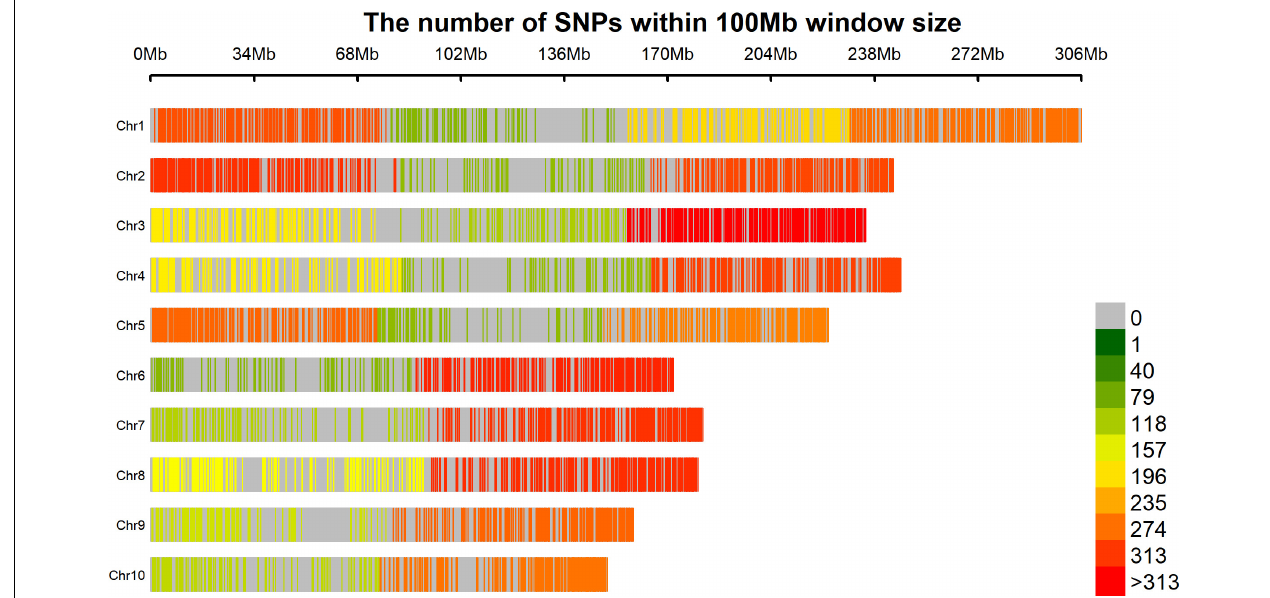
FIGURE 7 | Result of coverage genome showing the SNP density within a 100 Mb window.